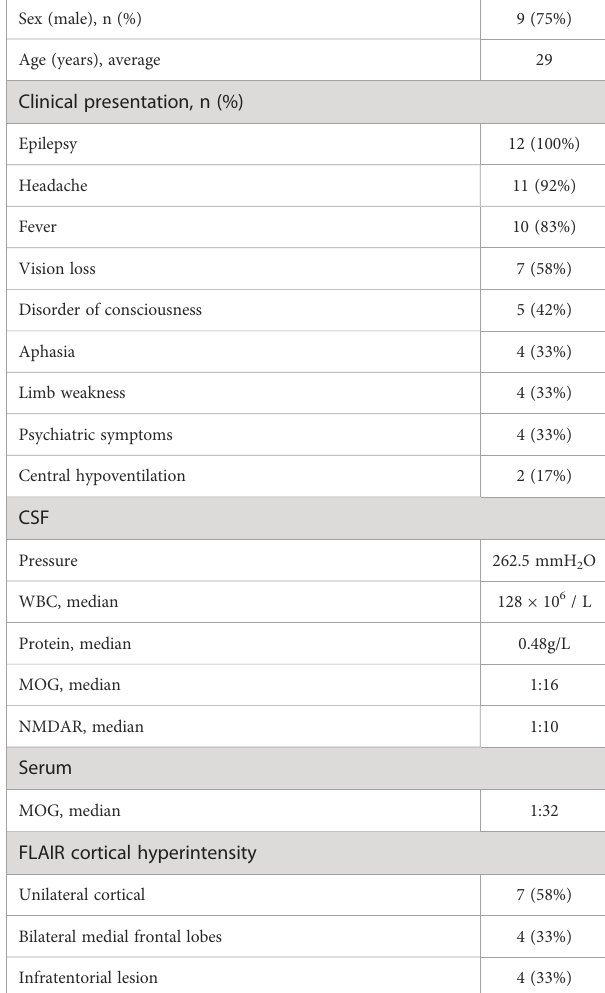
TABLE 2 Demographic and clinical data on all